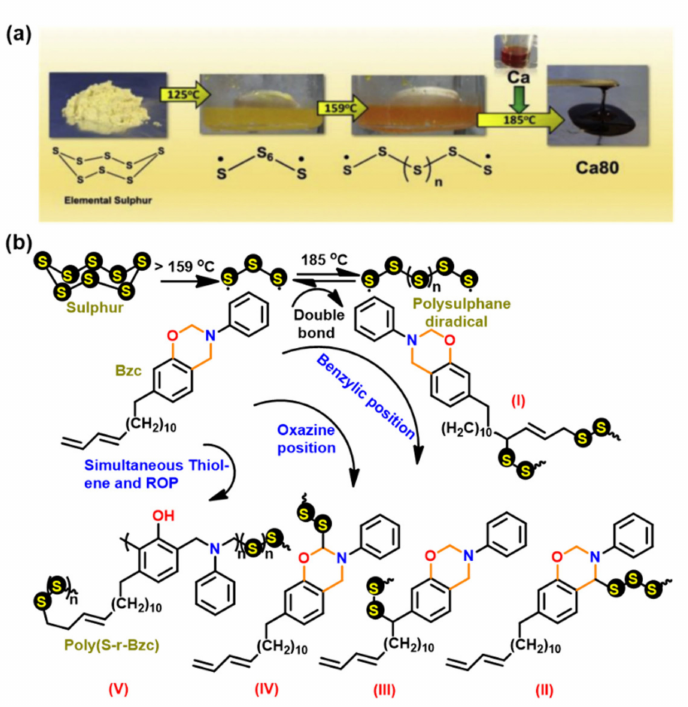
Figure 42. ( a ) Optical images at various stages of copolymerization of elemental sulfur with C- a [21]. Copyright 2016. Reproduced with permission from Elsevier Ltd. ( b ) Probable structure of copolymer formed by reaction of elemental sulfur and C-a of copolymerization [19]. Copyright 2014. Reproduced with permission from WILEY-VCH Verlag GmbH & Co. KGaA, Weinheim.